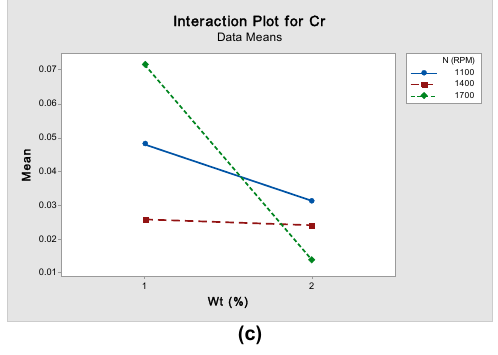
Figure 13. Interactive effect of SiC content and: (a) ultrasonic (US) vibration, (b) feed rate and (c) spindle speed; on circularity error.